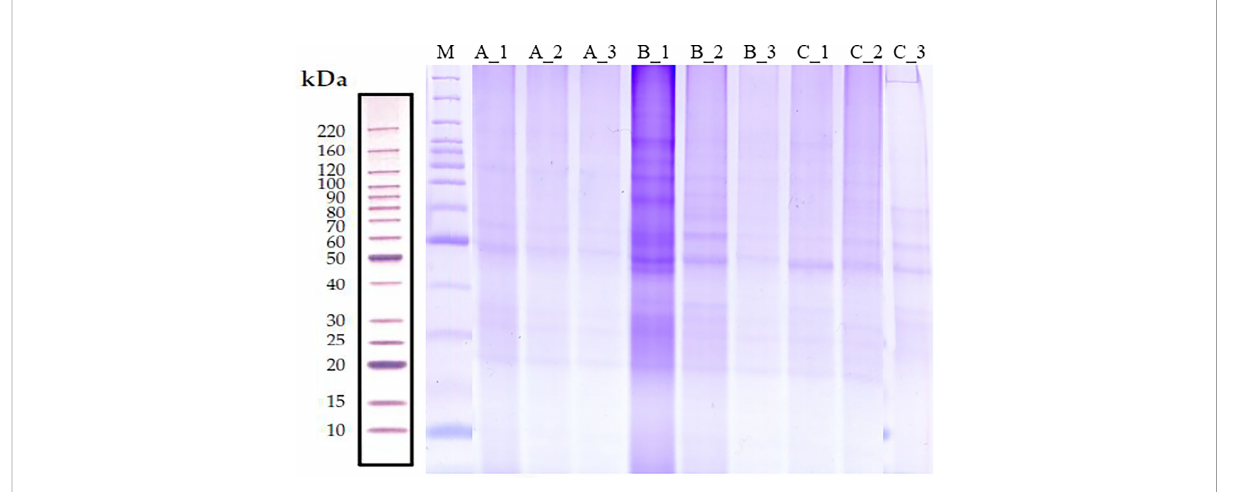
FIGURE 1 Analysis of protein quality of S. japonica at different stage levels. The total content of proteins isolated from S. japonica optic gland (groups A, C and D) were analyzed by